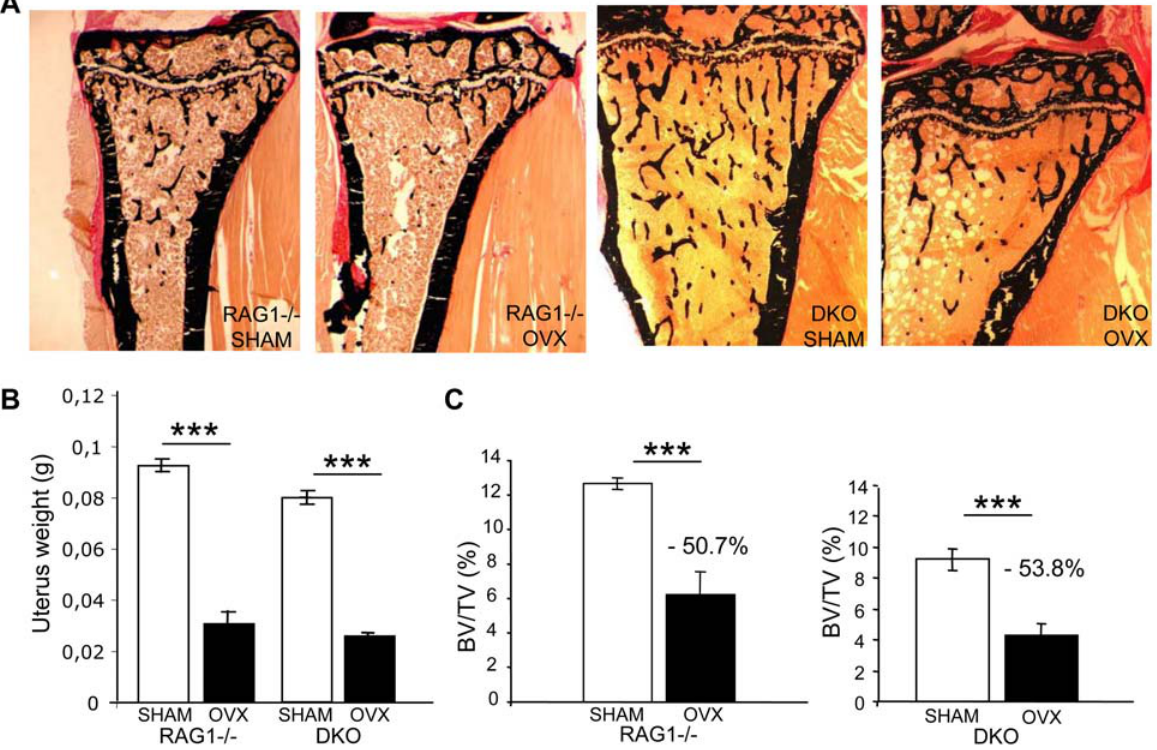
Figure 5. Mature lymphocytes and DAP12 protect against gonadal failure induced bone loss. Ovariectomies were performed on 8-week-old Rag1-/- and DKO mice. Four weeks later, both ovariectomized and sham operated animals were sacrificed. (A) Bone mass was assessed by histomorphometric analysis after Von Kossa/Von Gieson staining. (B) The efficiency of ovariectomy was evaluated by weighing the uteri. (C) Results of the quantification show that Rag1-/- mice, as well as K D 75;Rag1-/- mice, lost more than 50% of their bone mass after ovariectomy. (*** or {{{ p , 0.0001) doi:10.1371/journal.pone.0000585.g005 PLoS ONE |